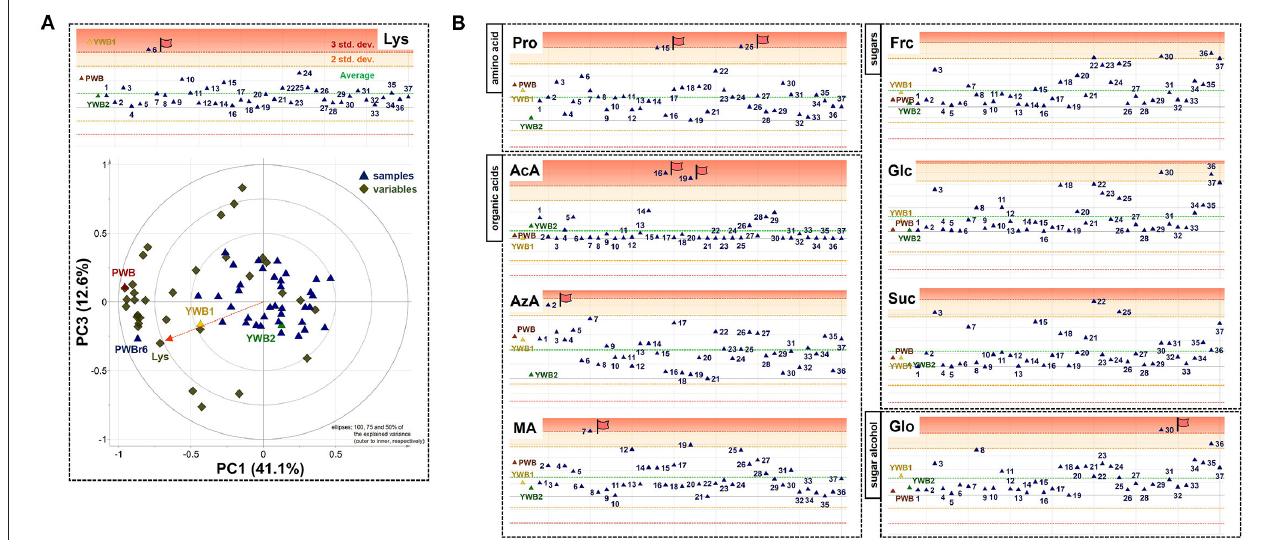
FIGURE 6 | (A) Xvar plot of lysine (Lys) (top) and biplot of PC1 against PC3 (bottom). (B) Xvar plots of proline (Pro), acetate (AcA), azelate (AzA), malate (MA) (left, top to bottom), fructose (Frc), glucose (Glc), sucrose (Suc), and glycerol (Glo) (right, top to